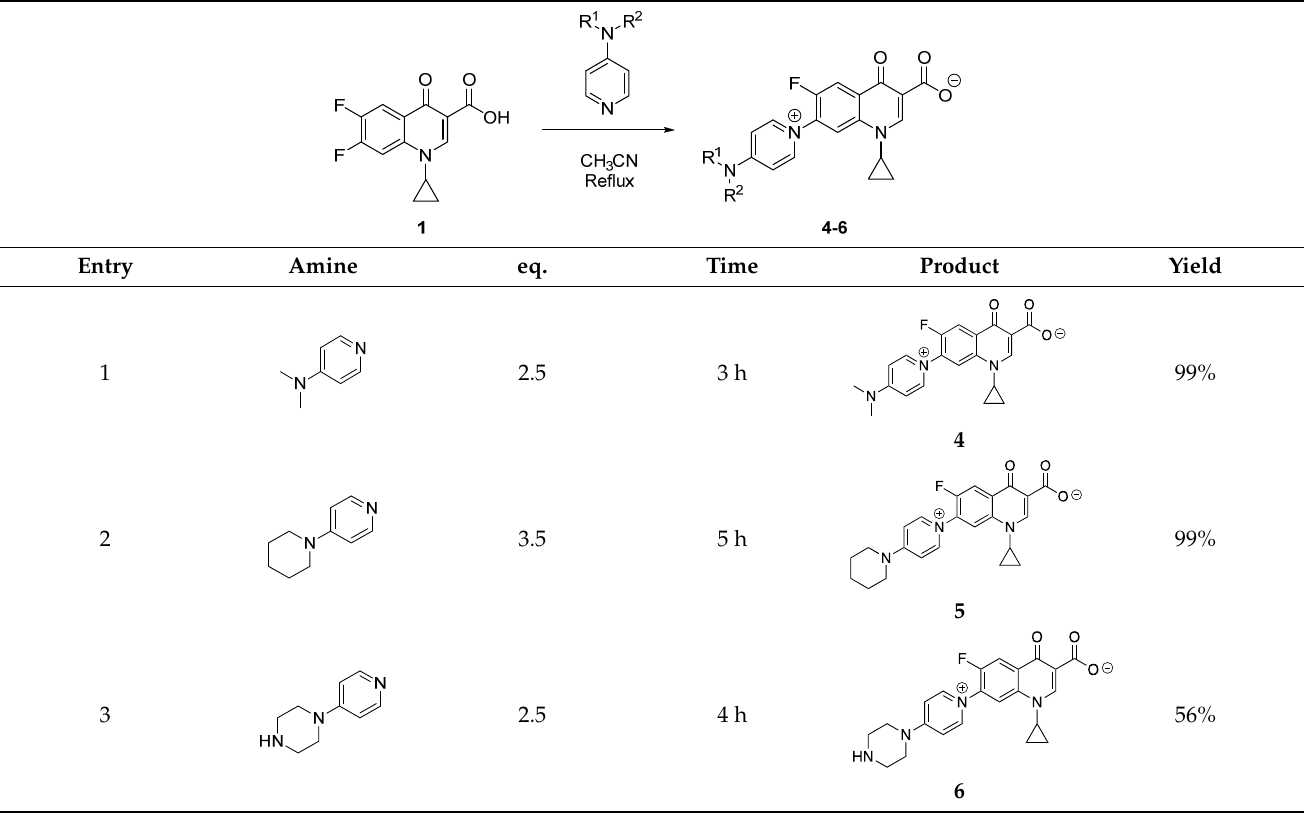
Table 2 . Reaction of 1 with DMAP derivatives and 1 ‐ methylimidazole.